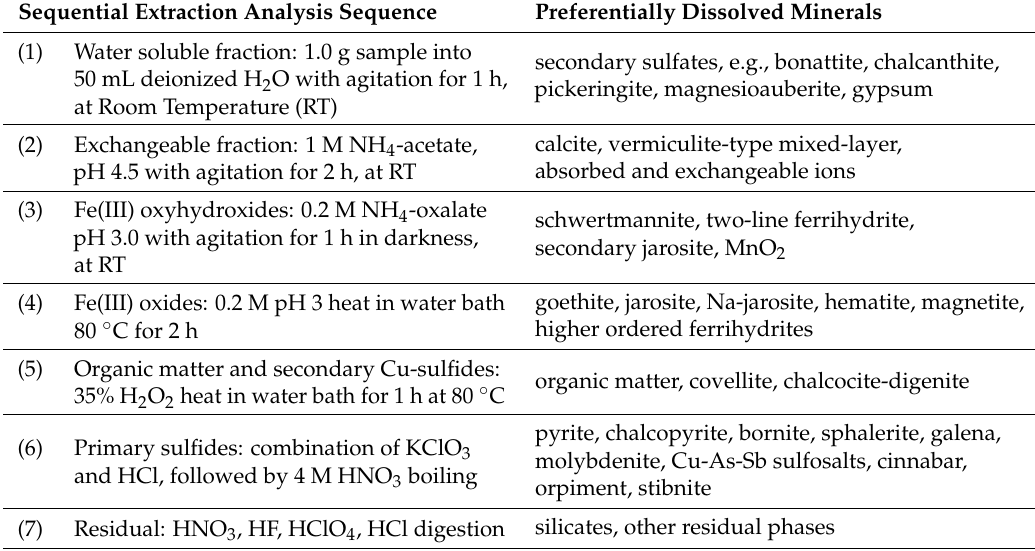
Table 1. Detail of sequential extraction procedure used in this study, modified after Dold